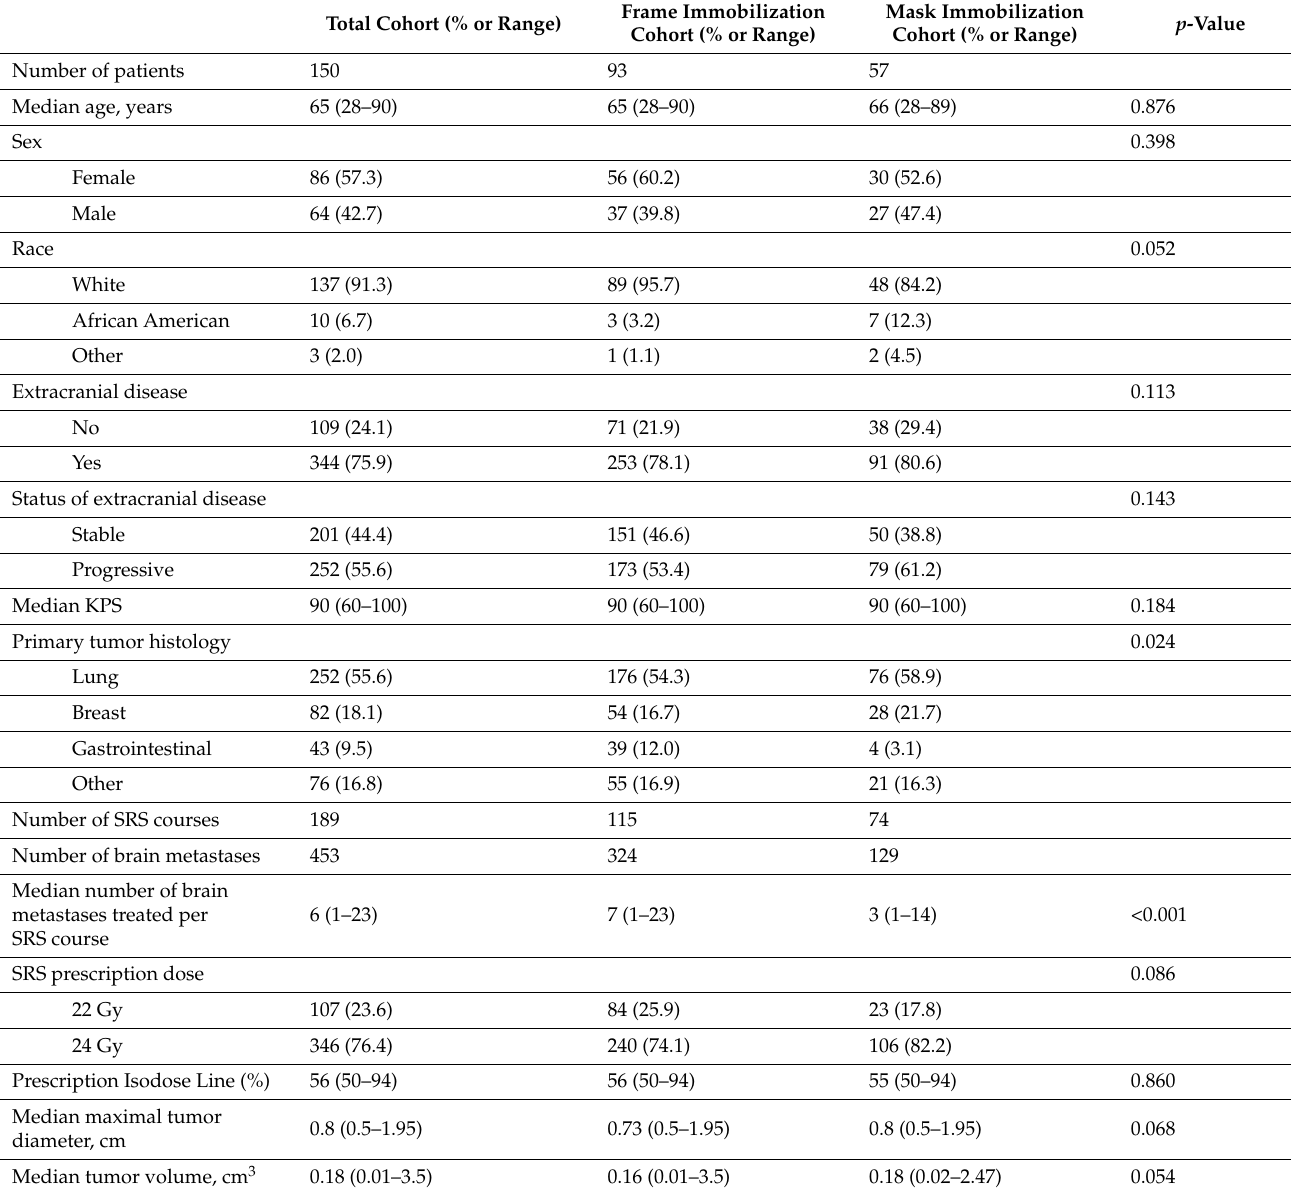
Table 1. Patient, tumor, and treatment characteristics of the total, frame, and mask immobilization cohorts. Total Cohort (% or Range)